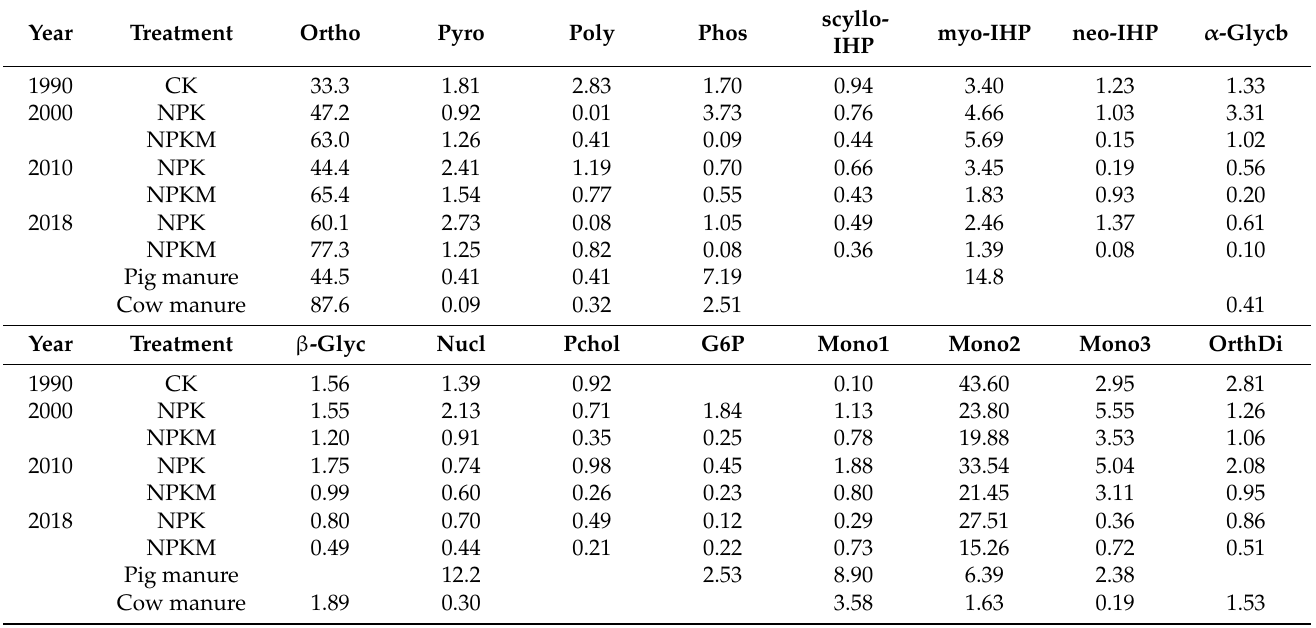
Table A1. The proportion of P fraction determined by integration of P-NMR signals of the studied soil under long-term field trial in Mollisol.